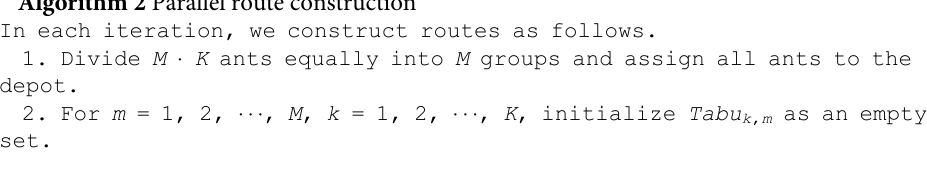
Algorithm 2 Parallel route